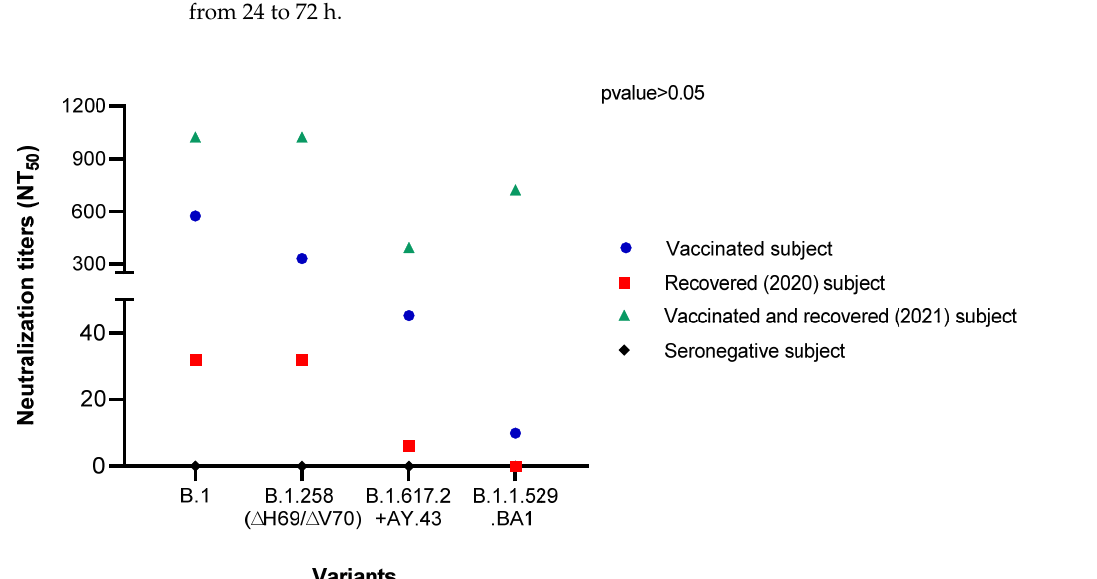
Figure 2. Growth curves of isolated variants, B.1.258 ( ∆ H69/ ∆ V70) (GISAID ID: EPI_ISL_7208675) and B.1.617.2+AY.43 (GISAID ID: EPI_ISL_7698448), and B.1.1.529.BA1 (EPI_ISL_10156328) compared with B.1, previously isolated (GISAID ID: EPI_ISL_584051). The viral loads, expressed as copies/mL, were quantified in supernatants by means of RT–qPCR targeting the SARS-CoV-2 N gene at 24, 48, and 72 h post-infection. The growth curves showed the same trend, with an increase in viral load from 24 to 72 h.